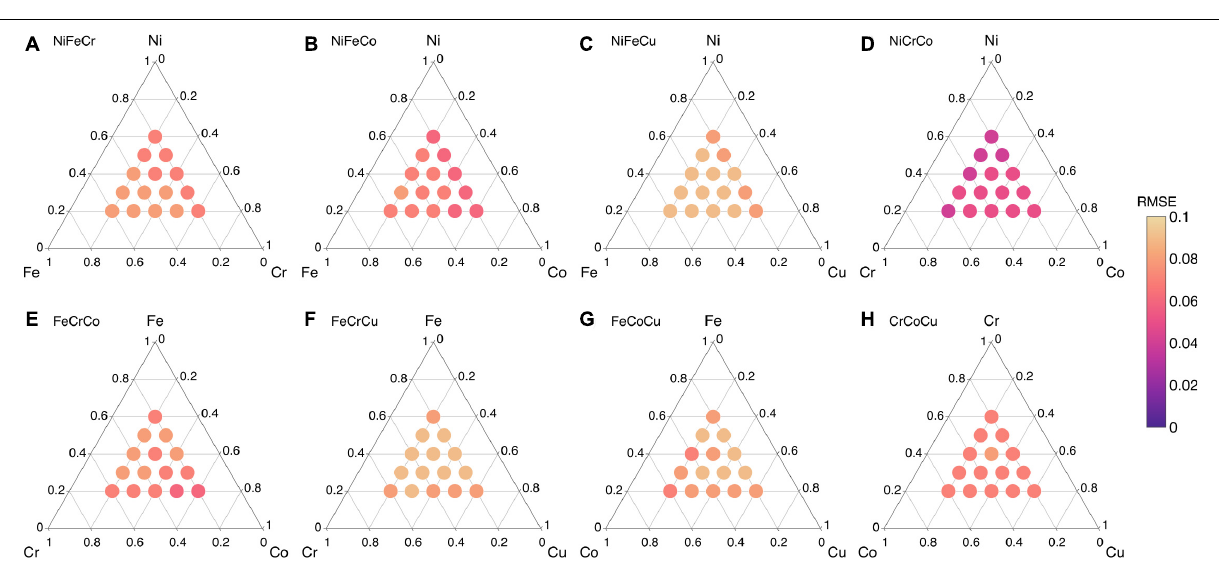
NiFeCu, FeCoCu, FeCoCu and CrCoCu are greater than 0.92, those of NiFeCr and FeCrCo are between 0.89 and 0.93, whereas those of NiFeCo and NiCrCo are between 0.83–0.9. Overall, we find that the migration energies of all eight ternary alloys are predicted with high R values, i.e., greater than 0.8. The corresponding RMSE values of all eight ternary alloys are shown in Figure 8 . We find that the RMSE values for all compositions are smaller than 0.1 eV; there are even smaller than 0.05 eV for NiCrCo as shown in Figure 8